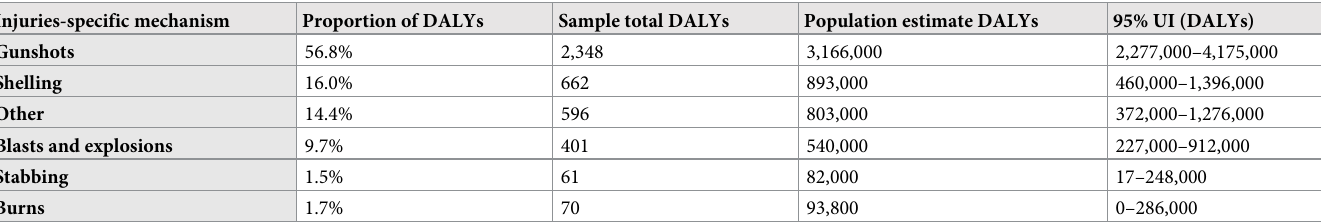
Table 1. Proportion of DALYs by cause, total DALYs by cause for the sample, and estimated DALYs for the population of Baghdad, Iraq, with 95% UI. Injuries-specific mechanism Proportion of DALYs Sample total DALYs Population estimate DALYs 95% UI (DALYs) Gunshots 56.8% 2,348 3,166,000 2,277,000–4,175,000 Shelling 16.0% 662 893,000 460,000–1,396,000 Other 14.4% 596 803,000 372,000–1,276,000 Blasts and explosions 9.7% 401 540,000 227,000–912,000 Stabbing 1.5% 61 82,000 17–248,000 Burns 1.7% 70 93,800 0–286,000